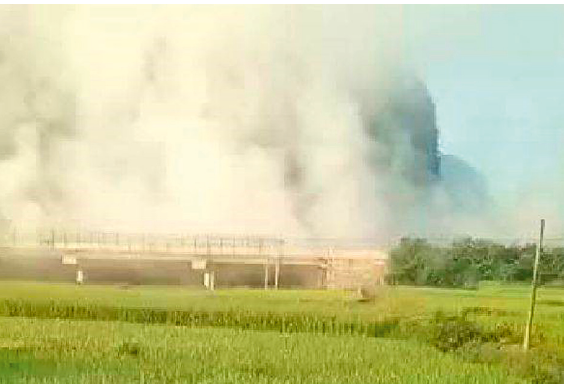
Figure 1: A hydrochloric acid truck overturn.